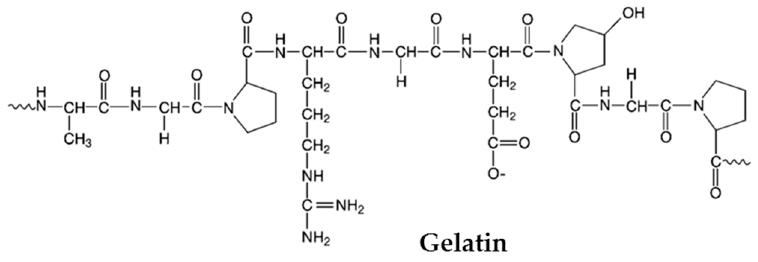
Figure 19. The structure of gelatin.